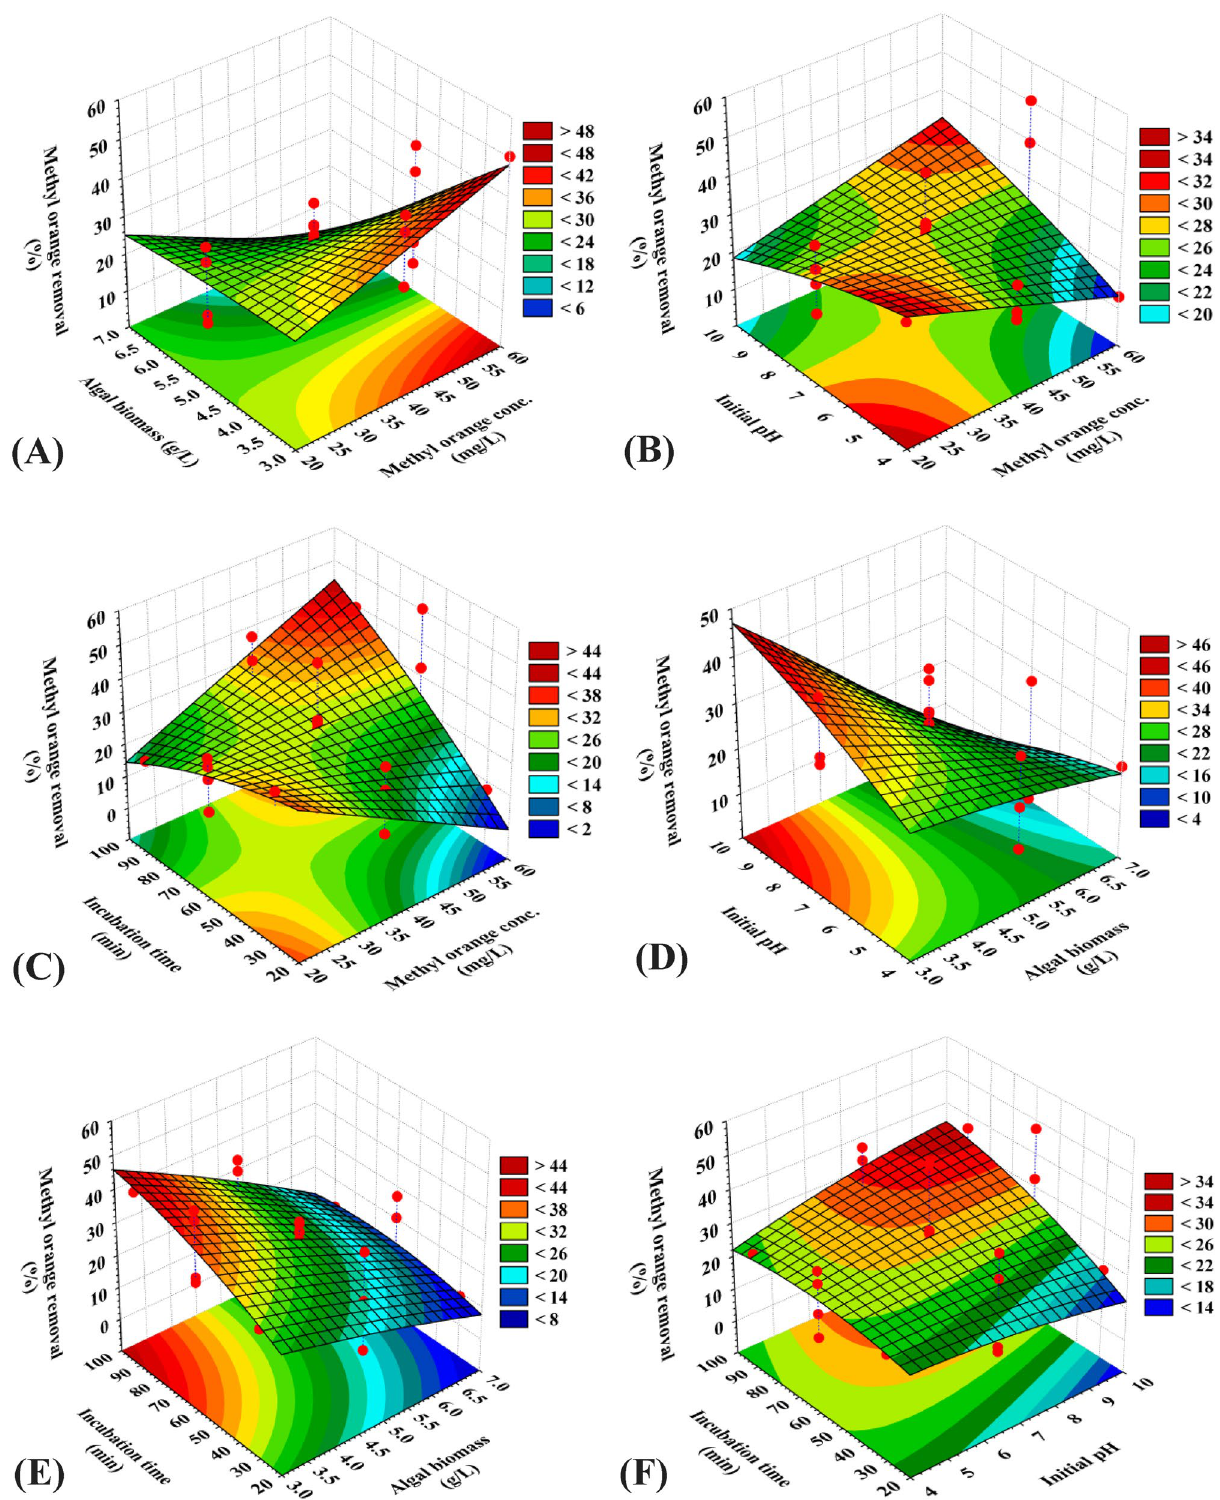
Figure 1. Three-dimensional surface plots of biosorption of methyl orange dye by Fucus vesiculosus biomass displaying the interactive effects of the four tested variables. This figure was created by using statistical software package, STATISTICA software (Version 8.0, StatSoft Inc., Tulsa,